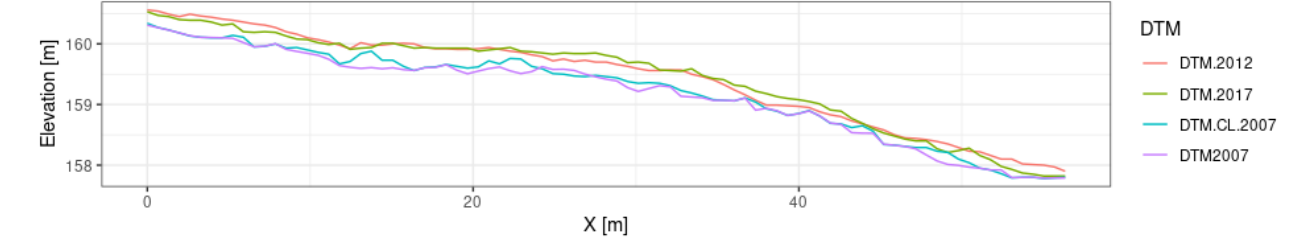
Figure 5. Comparison of profiles of the digital terrain models (DTMs) covering the same circular sample plot.